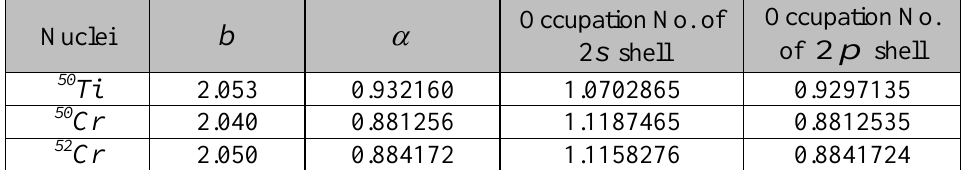
Table 2: The calculated values of b (in unit of fm ),  and the proton occupation numbers of 2s and p2 shells. Nuclei b